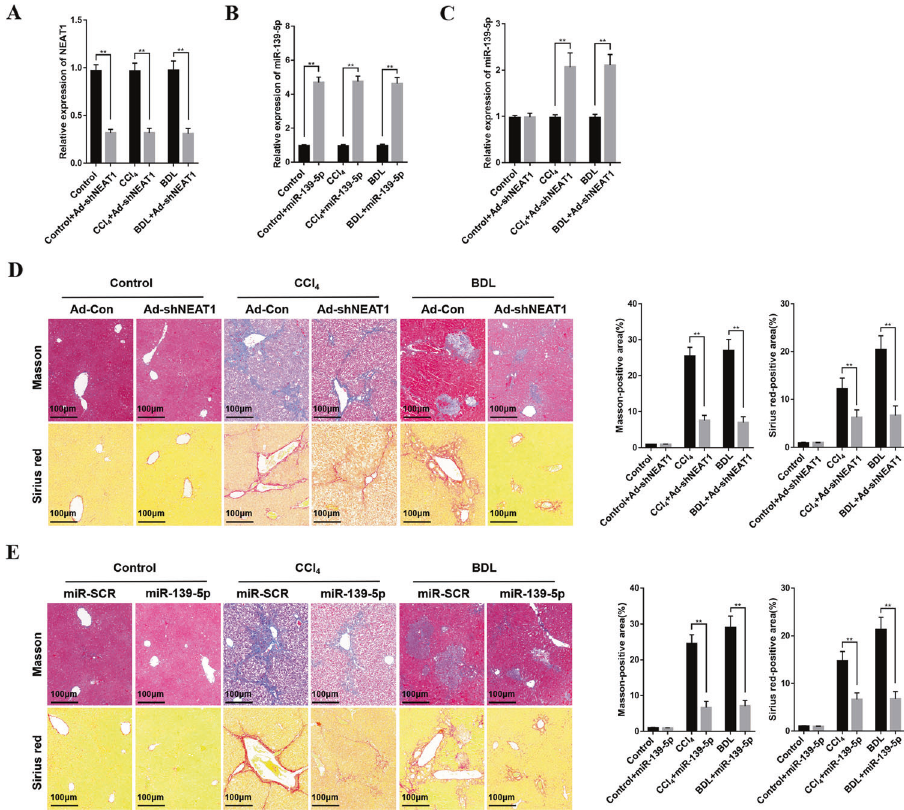
Fig. 7 Downregulation of NEAT1 and overexpression of miR-139-5p alleviates hepatic fi brosis in mice. A The expression levels of NEAT1 was examined in liver tissues from fi brotic mice transfected with Ad-Con or Ad-shNEAT1. n = 6/group. B The expression levels of miR-139-5p in liver tissues from fi brotic mice transfected with agomir control and ago-miR-139-5p were examined by qRT-PCR. n = 6/group. C The expression levels of miR-139-5p in liver tissues from fi brotic mice transfected with Ad-Con or Ad-shNEAT1 were detected. n = 6/group. D The liver tissues from fi brotic mice transfected with Ad-Con or Ad-shNEAT1 were treated with Masson staining and Sirius red staining, n = 6/group, original magni fi cation×200. E The liver tissues from fi brotic mice infected with agomir control and ago-miR-139-5p were treated with Masson staining and Sirius red staining, n = 6/group, original magni fi cation×200. Graph represents mean ± SD. * P < 0.05, ** P <